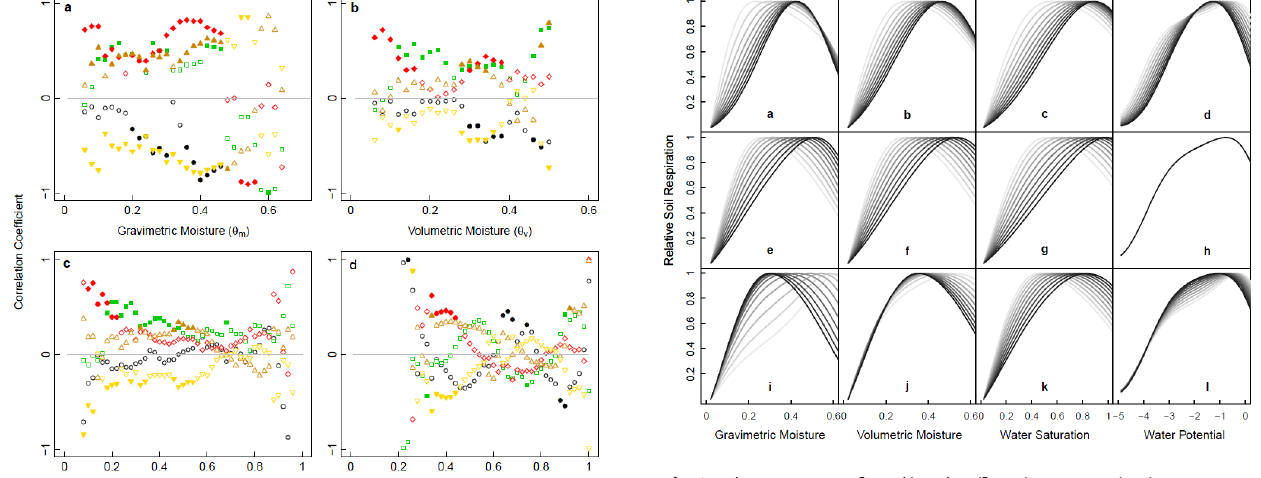
Fig. 3. The response of predicted soil moisture-respiration curves to variations in soil properties for mineral soils. Darker lines represent higher values of a given property. Variations are shown for clay content from 0.1 to 1 fraction ( a – d ), organic carbon from 0.005 to 0.05gg − 1 ( e – h ), and bulk density from 0.6 to 1.6gcm − 3 ( i – l ). The respective values for the variables held constant are: 0.3 fraction, 0.02gg − 1 and 1.2gcm − 3 . Moisture units are: gH 2 O gSoil − 1 ( a , e , i ), cm 3 H 2 O cm − 3 ( b , f , j ), cm 3 H 2 O cm − 3 pore-space ( c , g , k ), and − log 10 | ψ | kPa ( d , f , l ).